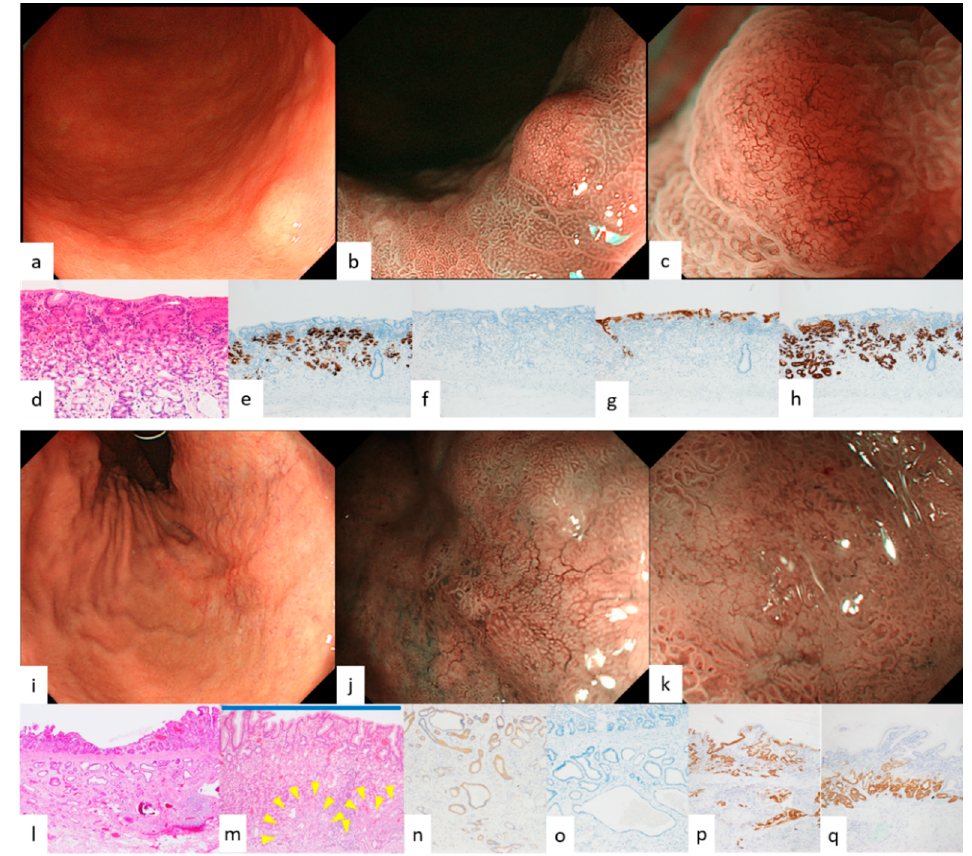
Figure 3. Endoscopic and pathological findings of GA-FGM (whitish elevated type, whitish flat or depressed type). ( a ) WLI. An SMT-like whitish elevated lesion, 5 mm in size, was found on the posterior wall of the greater curvature of the gastric body. Atrophic changes were observed in the background mucosa and no dilated vessels with branching architecture were found; ( b , c ) M-NBI. A distinct DL was observed, and microvessels with tortuosity and difference in caliber, if not highly atypical, formed the network. An irregular MV pattern plus absent MS pattern with a DL were observed by the MESDA-G; the lesion was diagnosed as cancerous. ( d ) HE stain. A differentiated adenocarcinoma differentiating into a foveolar epithelium-like structure was exposed on the surface, and tumor cells similar to chief cells proliferated primarily in the middle and deep layers of the mucosa; ( e – h ) Immunostain.; ( e ) pepsinogen-I (chief cell). Positive in the middle and deep layers; ( f ) H+/K+-ATPase (parietal cell). Negative; ( g ) MUC5AC (gastric foveolar epithelial cell). Positive in the surface layer; ( h ) MUC6 (gastric mucous neck cell). Positive in the middle and deep layers; Final pathological diagnosis: M, type 0-I, 5 mm, gastric adenocarcinoma of fundic gland mucosa type, pT1a/M, UL0, Ly0, V0, HM0, VM0. ( i ) A whitish depressed lesion, 25 mm in size, with indistinct borders was found in the lesser curvature of the middle body of the stomach. Atrophic changes were observed in the background mucosa, and dilated vessels with branching architecture were observed on the surface; ( j ) M-NBI. The DL was indistinct, and an oval MCE and dilatation of IP were observed; ( k ) M-NBI. An irregular MV plus absent MS pattern without a DL were observed by the MESDA-G; the lesion was diagnosed as non-cancerous; ( l ) HE stain. The tumor extended laterally, primarily in the deep mucosa, and invaded the submucosa over a wide area, up to 1200 μ m deep. In the surface layer, a well-differentiated adenocarcinoma existed with low-grade atypia